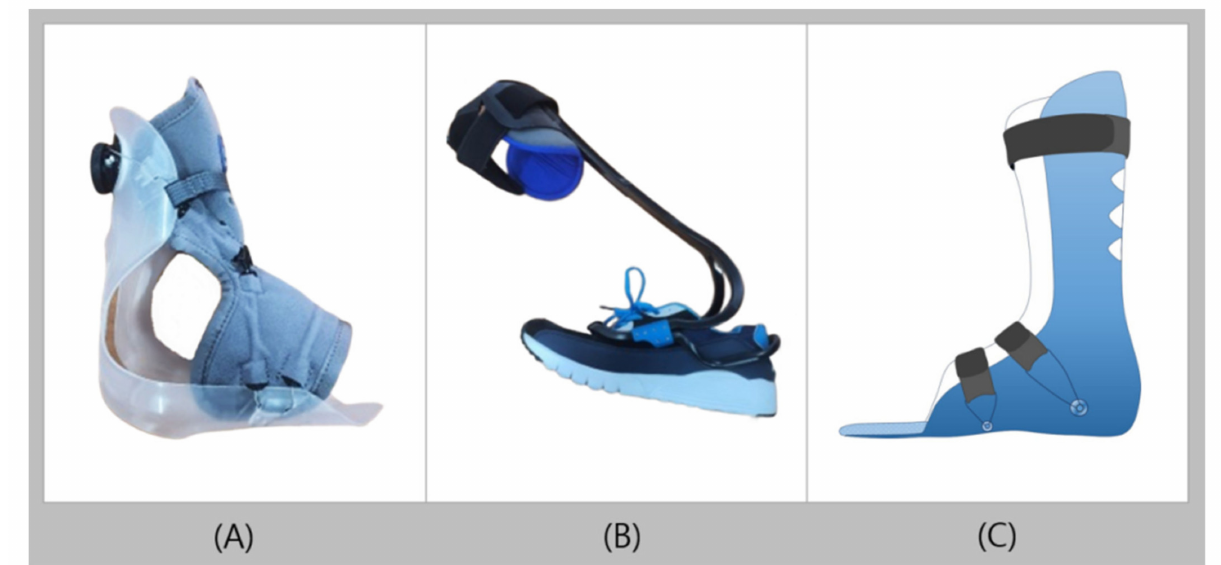
Figure 4. Recent trends of ankle-foot orthoses ( A ): AF Servo, ( B ): TurboMed, and ( C ): three-dimensionally printed